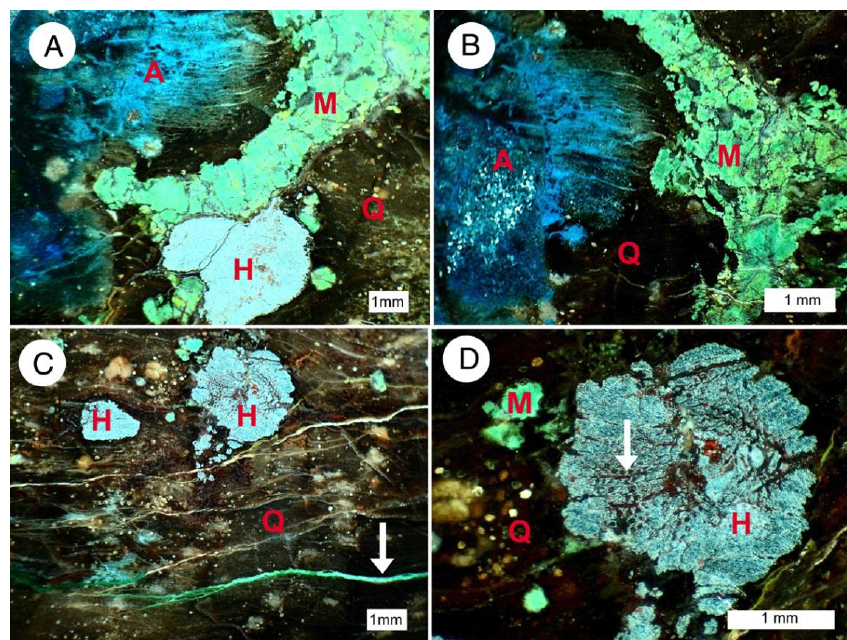
Figure 24. Reflected light microscope images. Abbreviations: A = azurite; M = malachite, H = hematite, Q = quartz (chalcedony). ( A , B ) Azurite has diffused along wood grain direction; ( C ) arrow marks malachite veinlet; ( D ) hematite sometimes shows rudimentary preservation of wood cell structure (arrow).